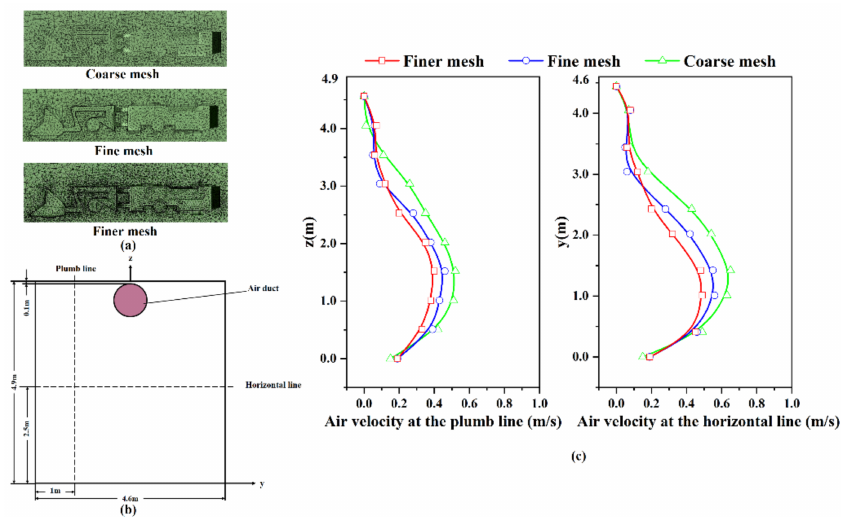
Figure 3. Process of mesh generation and mesh independence tests. ( a ) Three kinds of mesh with different elements; ( b ) Location for the comparisons of the air velocity at the plane of X = 10 m; ( c ) Comparisons of the simulated air velocities under the three different mesh elements.